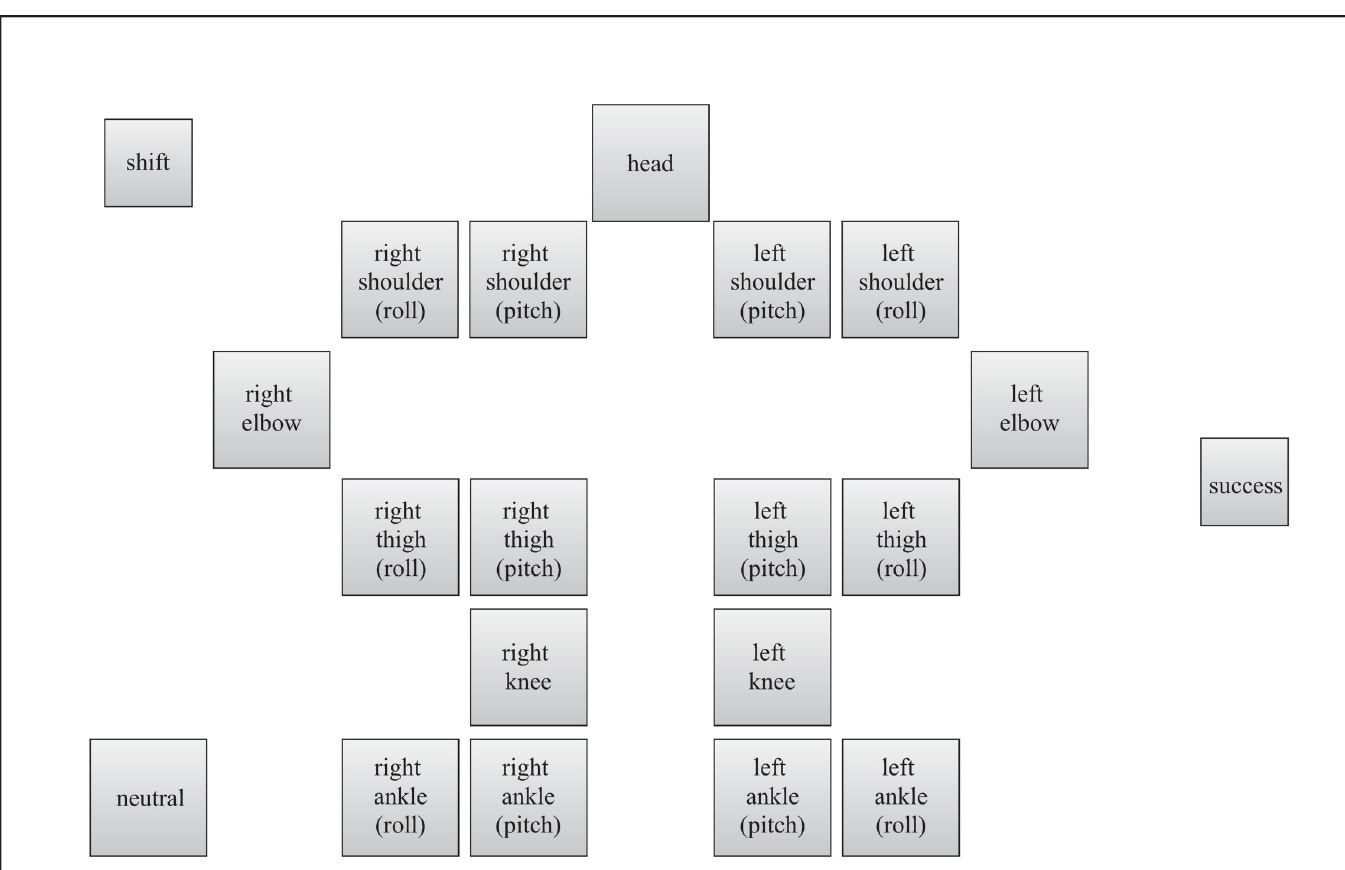
Fig 2. Command layout of the normal controller displayed on the tablet